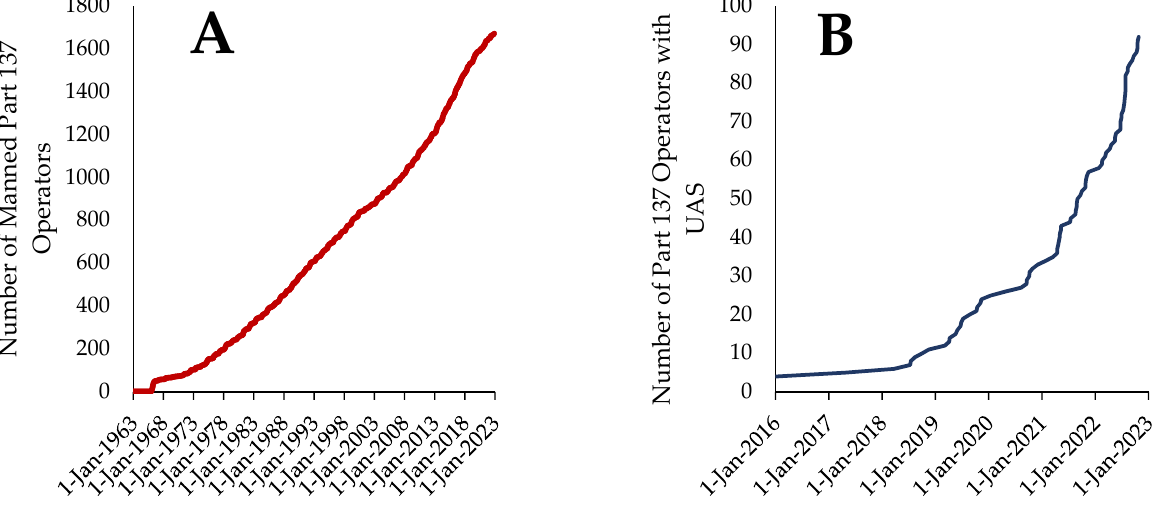
Figure 1. The total number of manned ( A , red) and unmanned ( B , blue) agricultural aircraft operators in the United States.